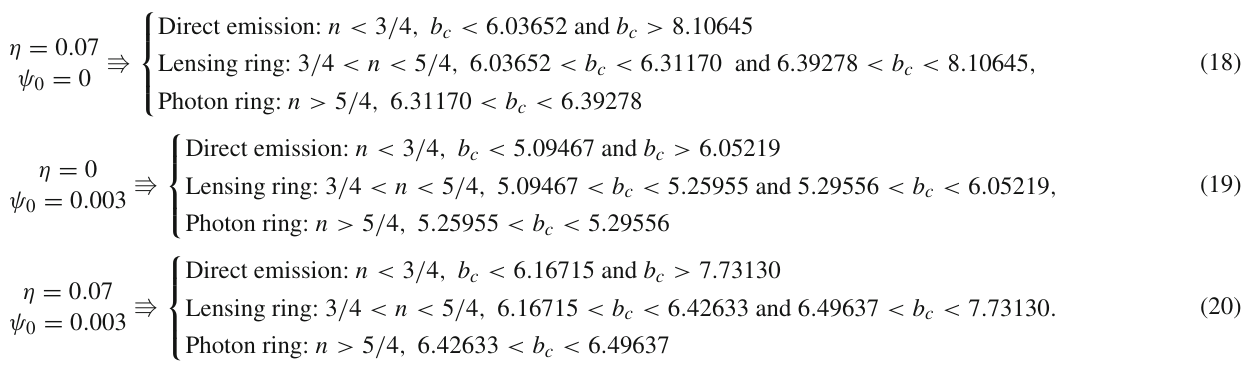
ring and photon ring trajectories correspond to the red line, blue line and green line, for which the related spacings of b c reads 1/5, 1/50 and 1/500, respectively. Similarly to Fig. 2, the photon orbit is the dashed grey line and black hole is presented as a solid